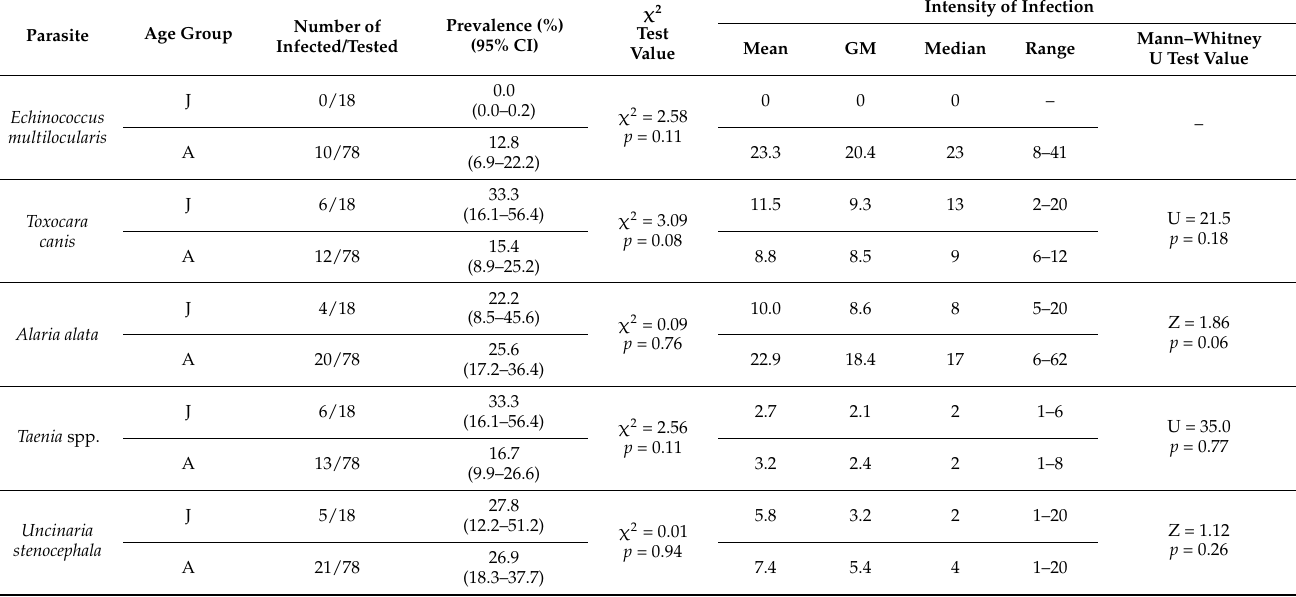
Table 1. Prevalence of gastrointestinal parasites in raccoon dogs with regard to host age (J—juvenile,